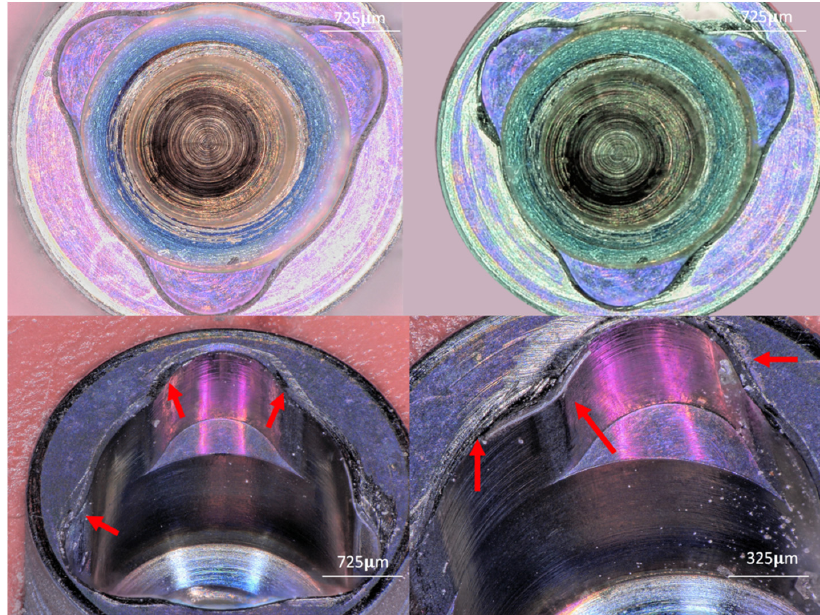
Figure 3. Upper left image shows a coronal view of Group B (Internal Three-Channeled). Upper right image shows a coronal view after implant insertion, the color-coded area is missing in some areas, and deformation of the channel wall is evident. Lower left image shows a close view of Group B after the insertion. The internal geometry is altered, deformation of the internal walls of the channel indicated by red arrows. Lower right image shows titanium particles at the implant platform and implant walls.